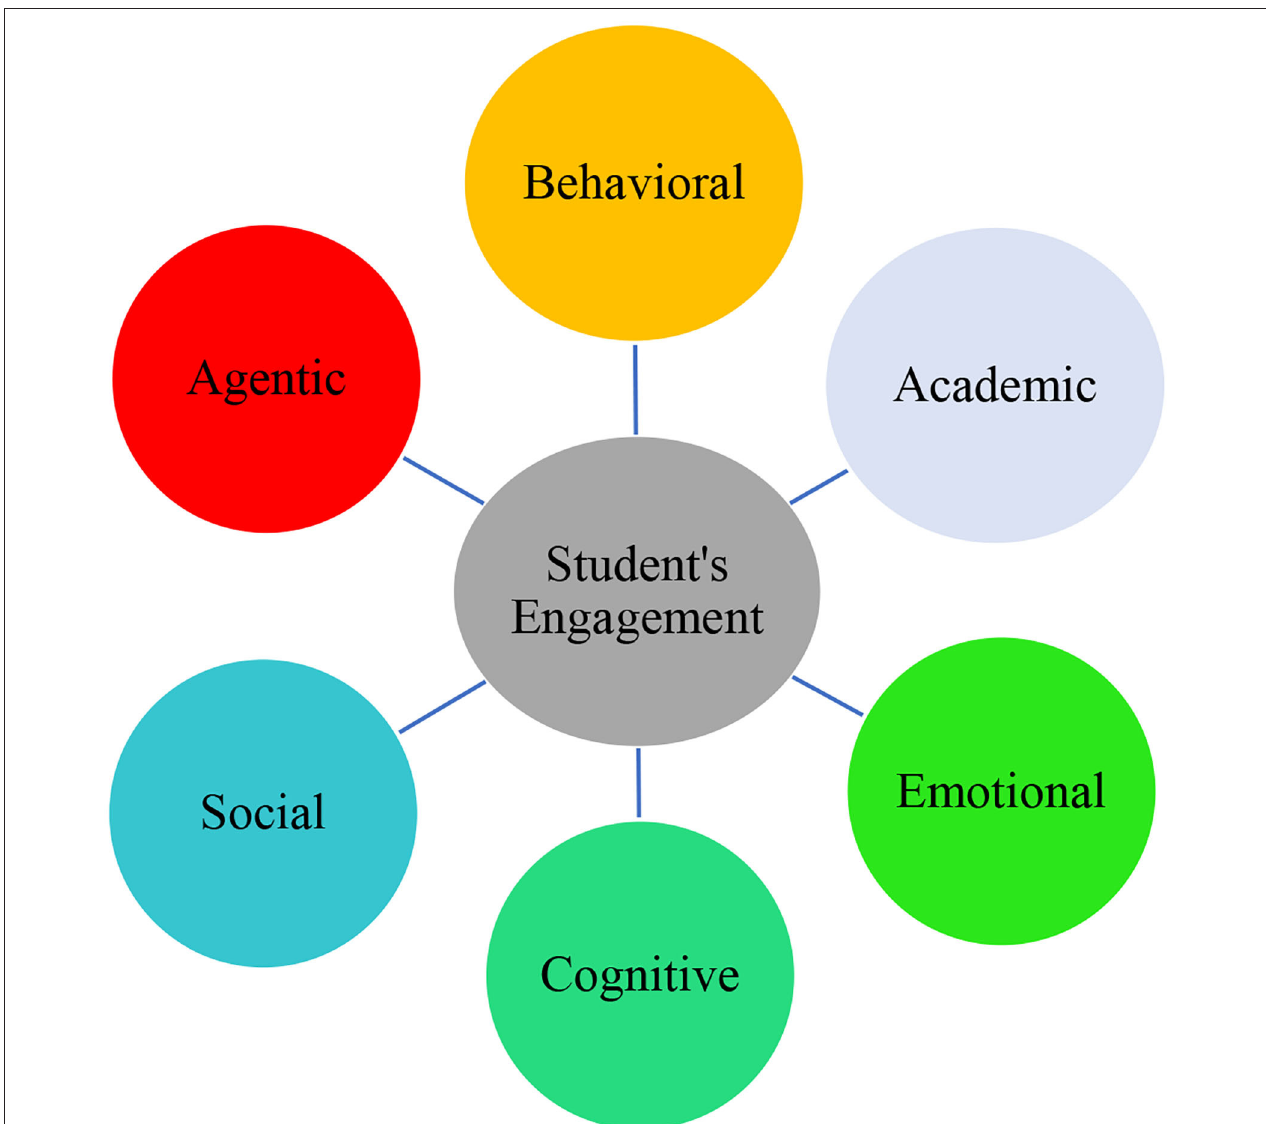
FIGURE 1 | The dimensions of student’s